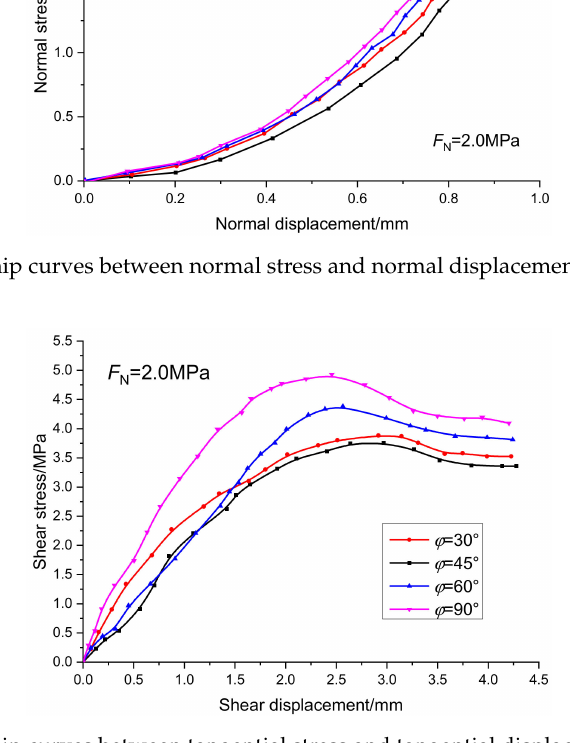
Figure 15. Relationship curves between tangential stress and tangential displacement under di ff erent joint dip